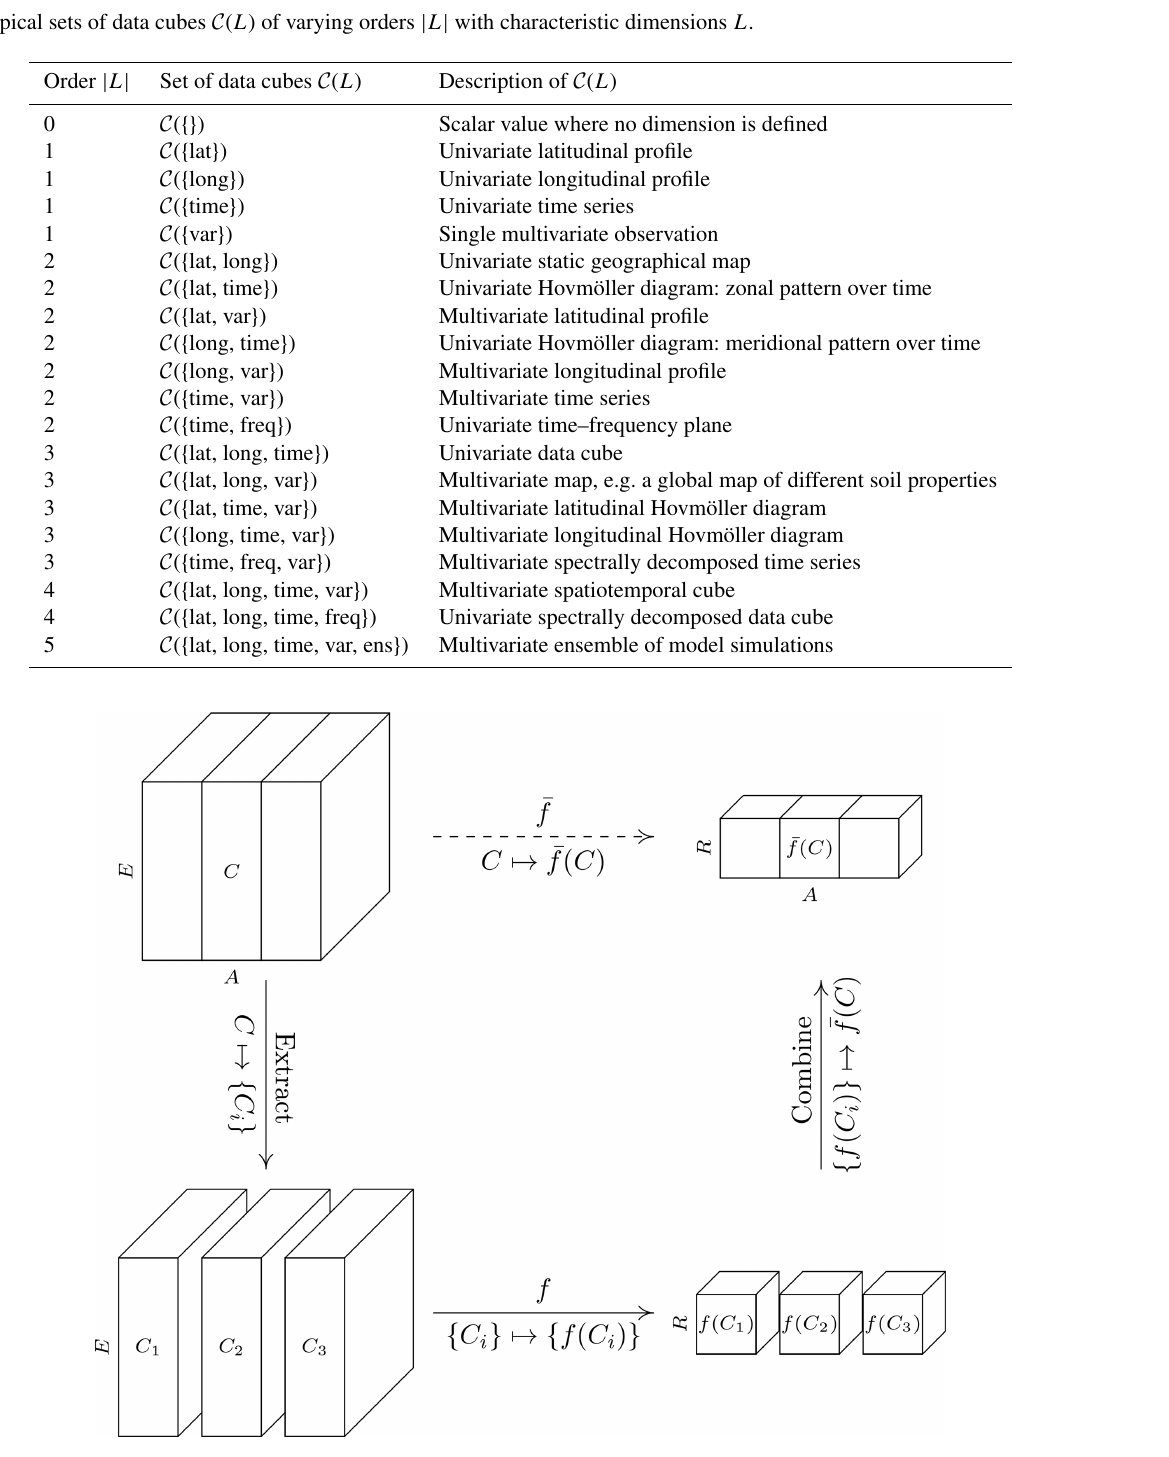
Figure 1. Schematic illustration of the “apply” functionality: a function f : C ( E ) → C ( R ) is extended to the set of cubes with dimensions E ∪ A , where A is an arbitrary set of dimensions with A ∩ R = ∅ . Given a cube C ∈ C ( E ∪ A ), the extension f ( C ) is constructed by iterating over all grid points i along the dimensions in A to obtain the collection { C i } ⊆ C ( E ) of sliced cubes, applying f to every cube C i separately, and binding the collection { f ( C i ) } into the output cube f ( C ) ∈ C ( R ∪ A ). Here, the index i runs through all elements in grid( a